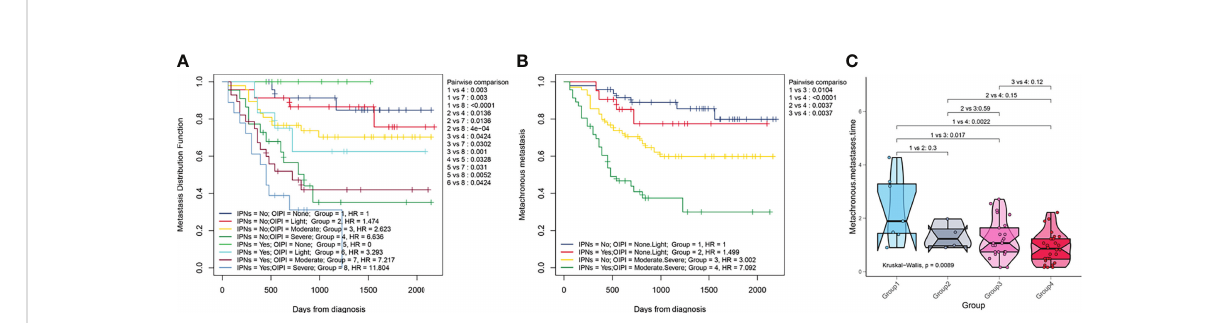
FIGURE 4 Effect of the combination of the OIPI and IPNs in predicting the MFS and metastatic time. (A) A total of 184 osteosarcoma patients were divided into eight groups according to the combination of OIPI and IPNs. The difference in metastatic predictive ability among eight groups was shown. (B) A total of 184 osteosarcoma patients were divided into four groups according to the combination of OIPI and IPNs. The difference in metastatic predictive ability among the four groups was shown. (C) The Kruskal – Wallis test demonstrated that there was a difference in metastatic time among the four groups (P = 0.0089). Patients in the moderate- and severe-OIPI groups developed metachronous metastasis earlier than those in the no-OIPI group (P = 0.017 and P = 0.0022, respectively). OIPI, osteosarcoma immune prognostic index; IPNs, indeterminate pulmonary nodules; MFS, metastasis-free